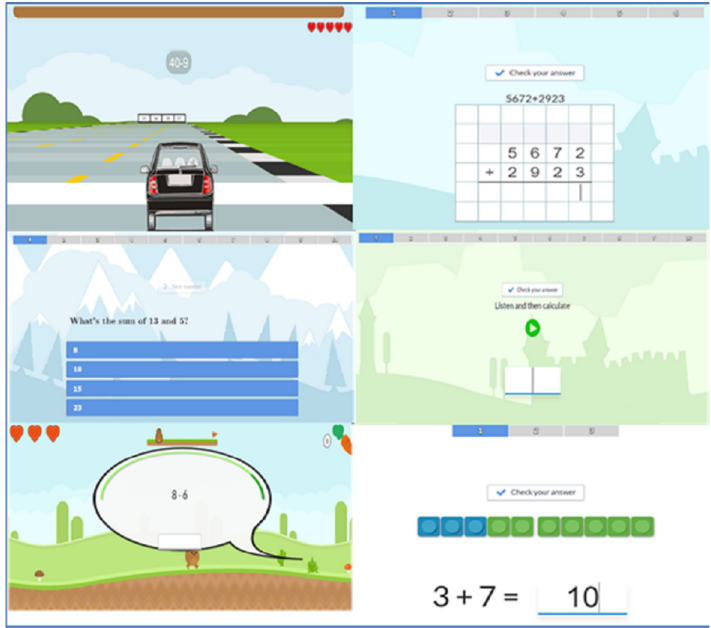
Figure 1. Indicative examples of the platform’s gamified exercises’ user interface.